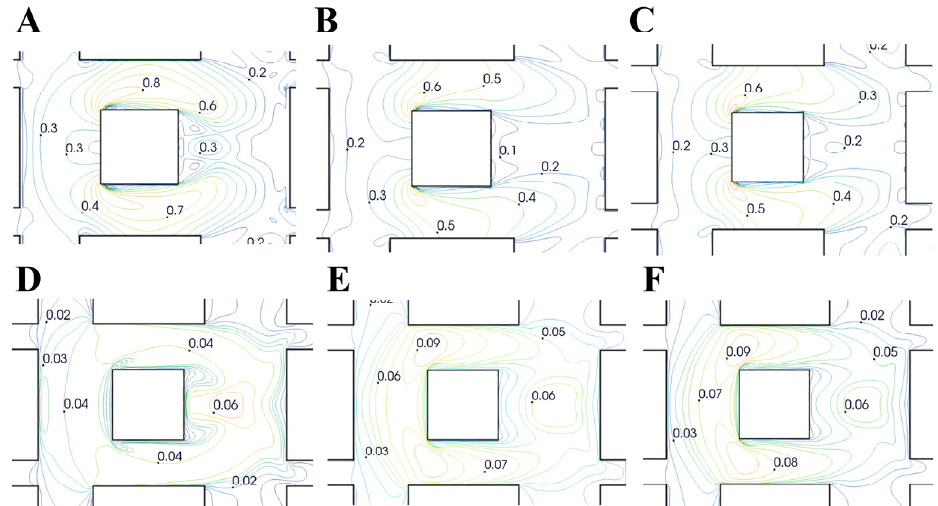
Figure 11. Contours of wind velocity on the 90 m plane were obtained by Butterfly using the ( A ) RNGKE, ( B ) STKE, and ( C ) SSTKW turbulence models, respectively; contours of wind velocity on the 2 m plane were obtained by Autodesk CFD using the ( D ) RNGKE, ( E ) STKE, and ( F ) SSTKW turbulence models,